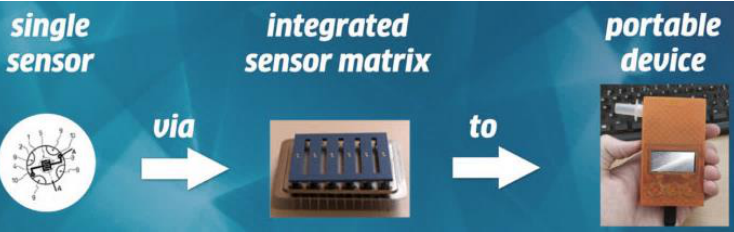
Figure 12. Investigation of the breath gas analysis of a Co 3 O 4 /CdS sensor. ( a ) The breath of a healthy experimenter is collected with an air bag. ( b ) The breathing of diabetic patients is simulated by in- jecting 2 ppm acetone into the exhaled breath of healthy people. ( c ) The response curve of the sensor in the environment of the simulated breath of diabetic patients. ( d ) The response value of the sensor tested upon exposure to simulated diabetes breath, 2 ppm acetone, and healthy breath [63]. 6. Conclusions and Futures Prospects In this review, metal oxide (MOx) gas sensors were investigated. A comparative study was presented of different micro- and nanostructures for the detection of acetone considering their potential use in the diagnosis of diabetes. The general properties and their gas detection mechanisms, with porous architecture, were also considered. This